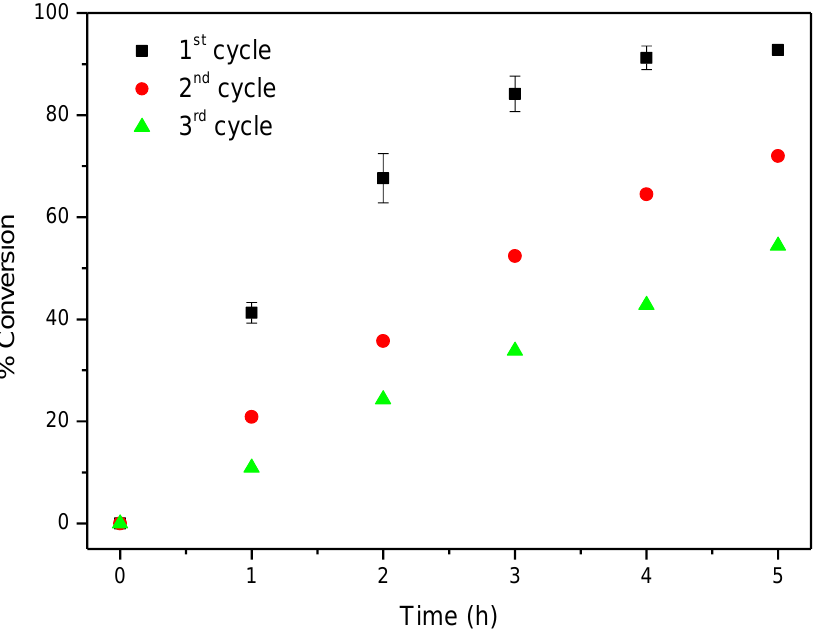
Figure 15. Oxidation of cyclooctene using CAT-5-MR as catalyst and TBHP as oxidant with additions of 0.5 eq. every 15 min.